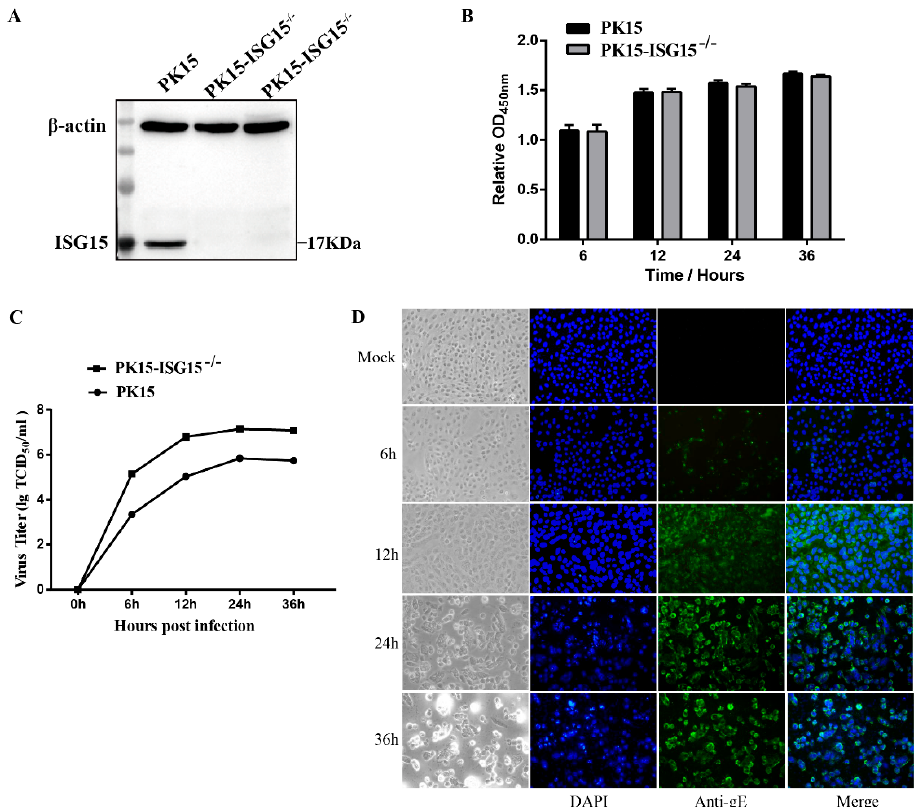
Figure 1. Establishment of the ISG15-knockout PK15 cell line. ( A ) Western blot analysis of ISG15 expression in PK15 cells and the ISG15 knockout sgRNA-1 and sgRNA-2 groups. ( B ) The effect of ISG15 knockout on PK15 proliferation was evaluated by an MTT assay. ( C ) One-step growth curve of PRV infection in ISG15 − / − -PK15 cells at the indicated time points following viral infection. The viral titer is presented in TCID 50 /mL. ( D ) Confirmation of PRV proliferation in ISG15 − / − -PK15 cells by IFA using the anti-PRV-gE mAb and Alexa Fluor 488-labeled goat anti-rabbit IgG (green); and mock-infected cells at 24 h was used as a negative control. Cell nuclei were stained with DAPI (blue) (400×). The data are presented as mean ± SD from triplicate experiments.